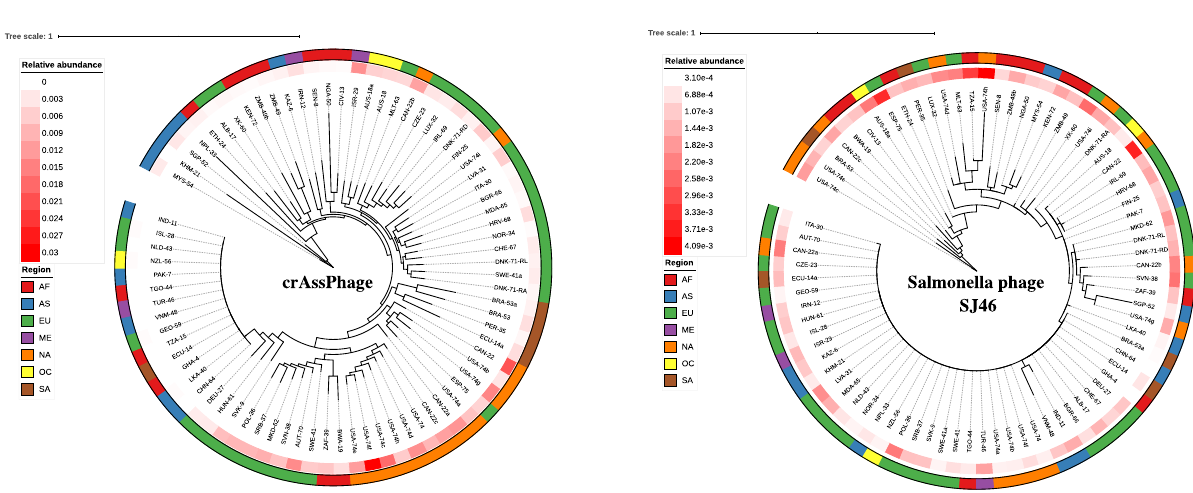
Figure 5. SNP trees of uncultured crAssphage (NC_024711, left) and Salmonella phage SJ46 (NC_031129, right). AF Africa, AS Asia, EU Europe, NA North America, ME Middle East, OC Oceania, SA South